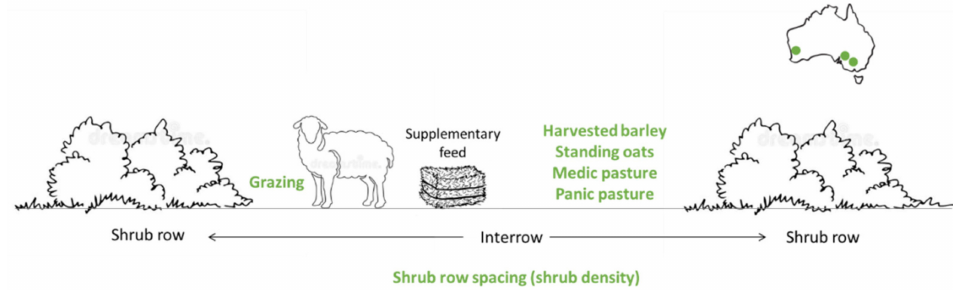
Figure 2. Conceptual overview of the study. Sheep graze the shrub, interrow and supplementary feed (i.e., hay) based on metabolizable energy requirements. Scenarios of different systems (indicated in green) were investigated that included different locations, grazing regimes, shrub density (determined by different interrow width) and interrow